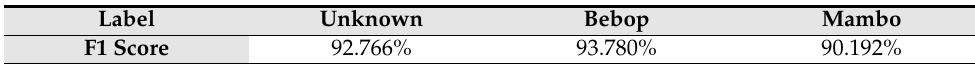
Table 14. F1 scores per label for